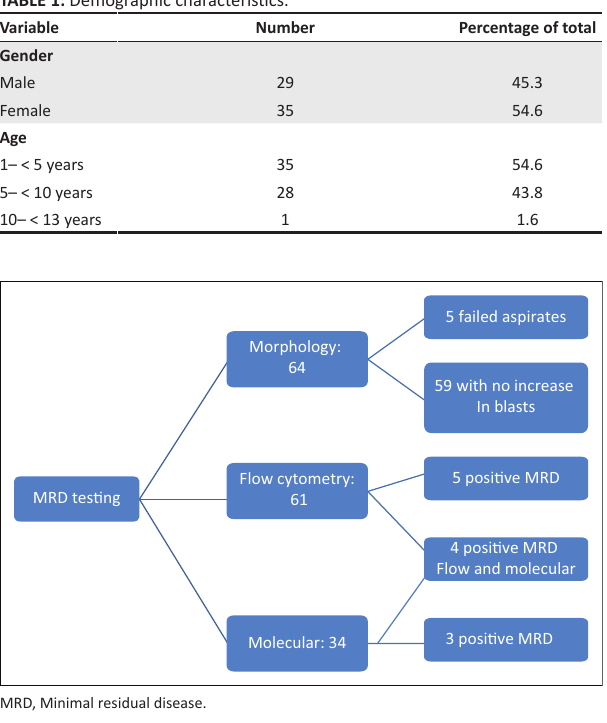
FIGURE 2: Post-induction minimal residual disease results. Minimal residual disease was detected in 12 patients, 9 by flow cytometric methods and 7 by molecular